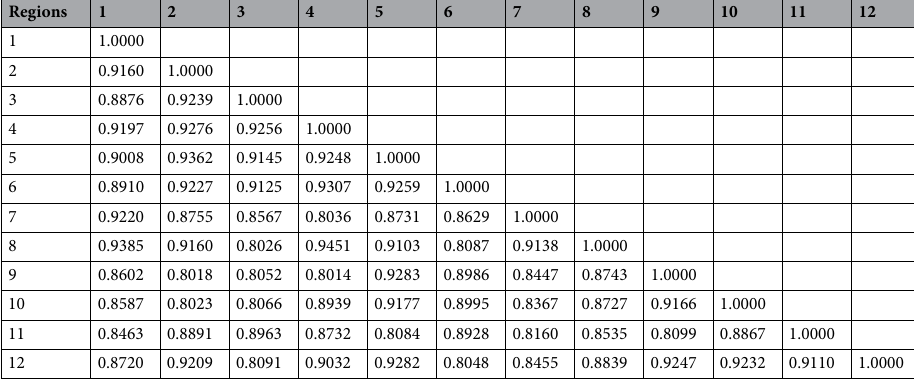
Table 7. Equivalence matrix for Karaj districts based on Maximum-Minimum